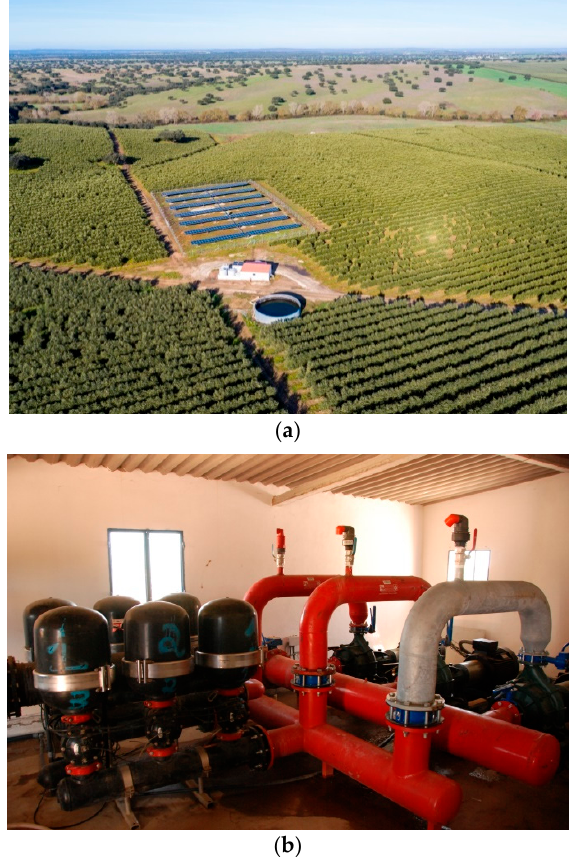
Figure 5. ( a ) Aerial view of the hybrid PV-diesel drip irrigation system. ( b ) Detail of the three motor-pumps and the water filter bench. The additional third pump is easily identifiable.